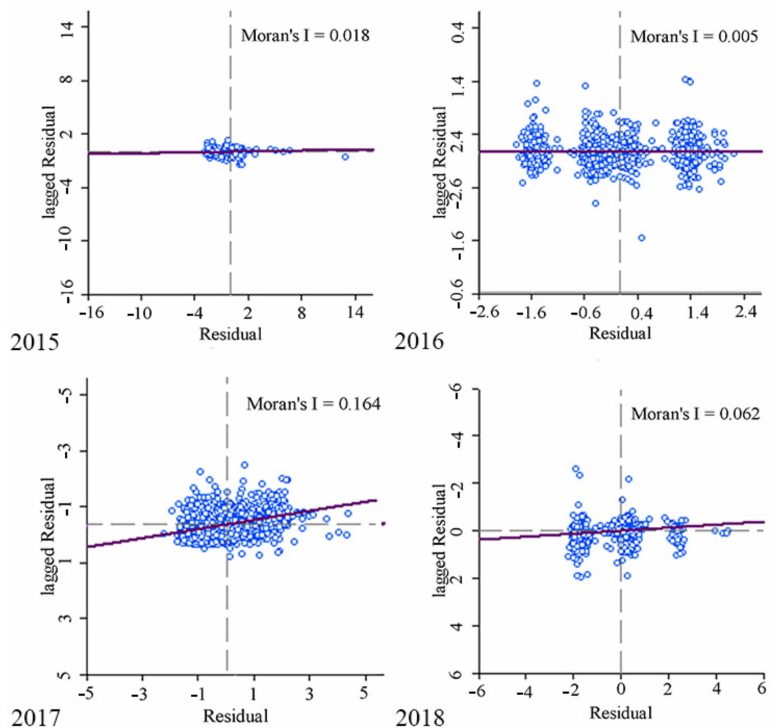
Figure 3. Moran scatter diagram of OLS regression residual terms of the household-level factors from 2015 to 2018.